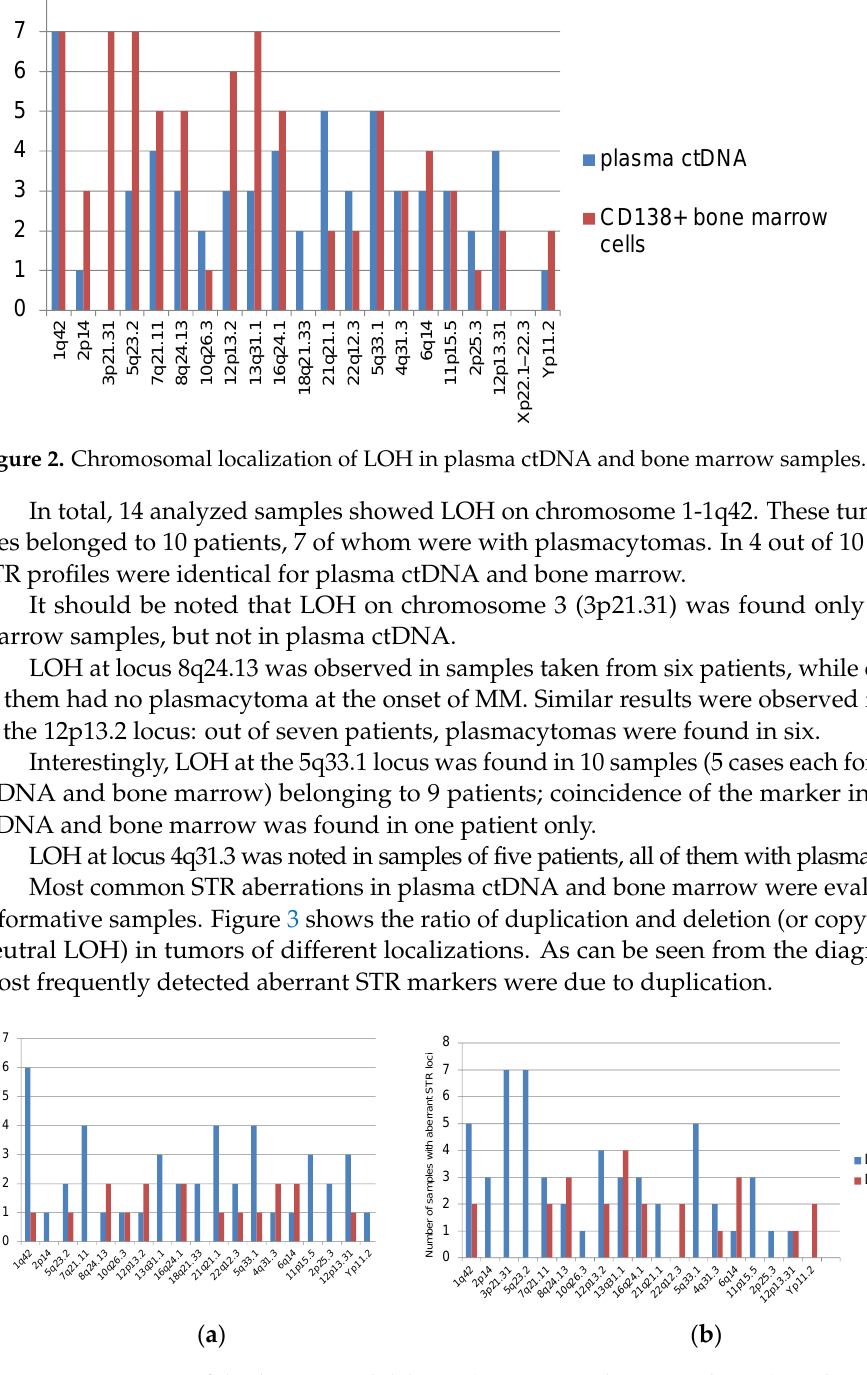
Table 3. LOH frequency in paired plasma ctDNA and bone marrow samples, depending on the presence of plasmacytomas. Parameter MM with plasmacytomas n = 25 MM without plasmacyto- mas n = 13